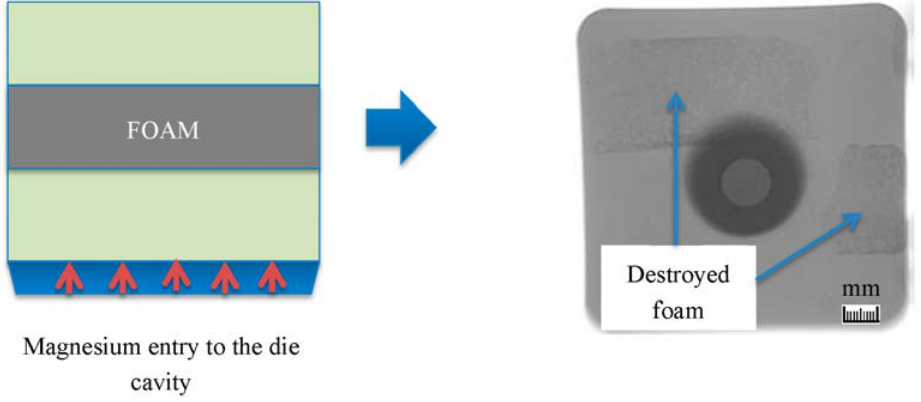
Figure 15. Horizontal placement to the metal flow of the core.